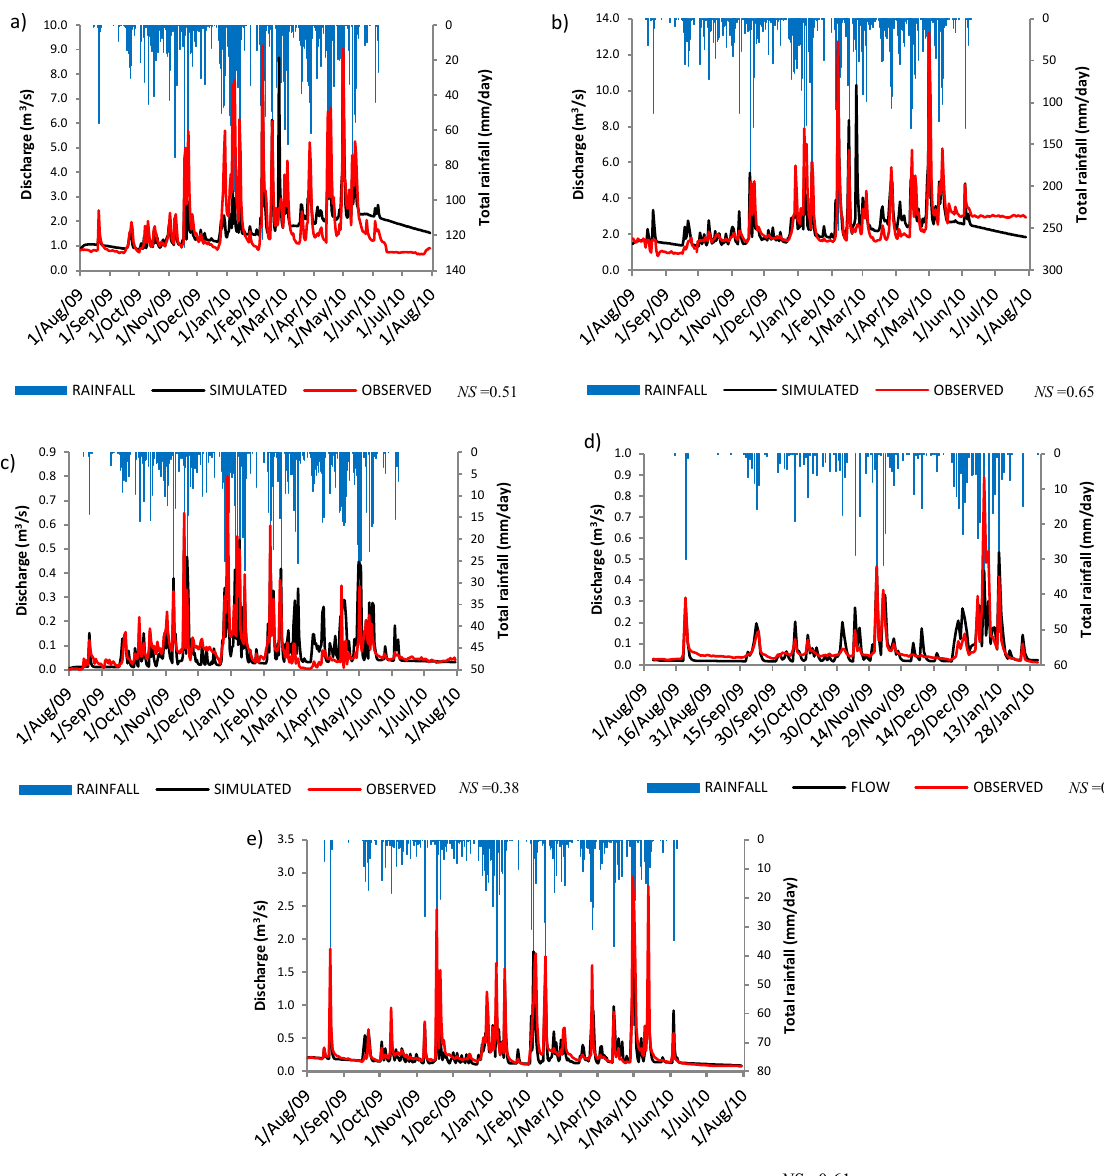
Figure 3. The simulated and observed hydrographs at (a) Cyihene-Kansi, (b) Migina outlet, (c) Munyazi, (d) Mukura and (e) Akagera Figure 3 The simulated and observed hydrographs at a) Cyihene-Kansi, b) Migina outlet, c) Munyazi, d) Mukura, and e) Akagera sub-catchments.